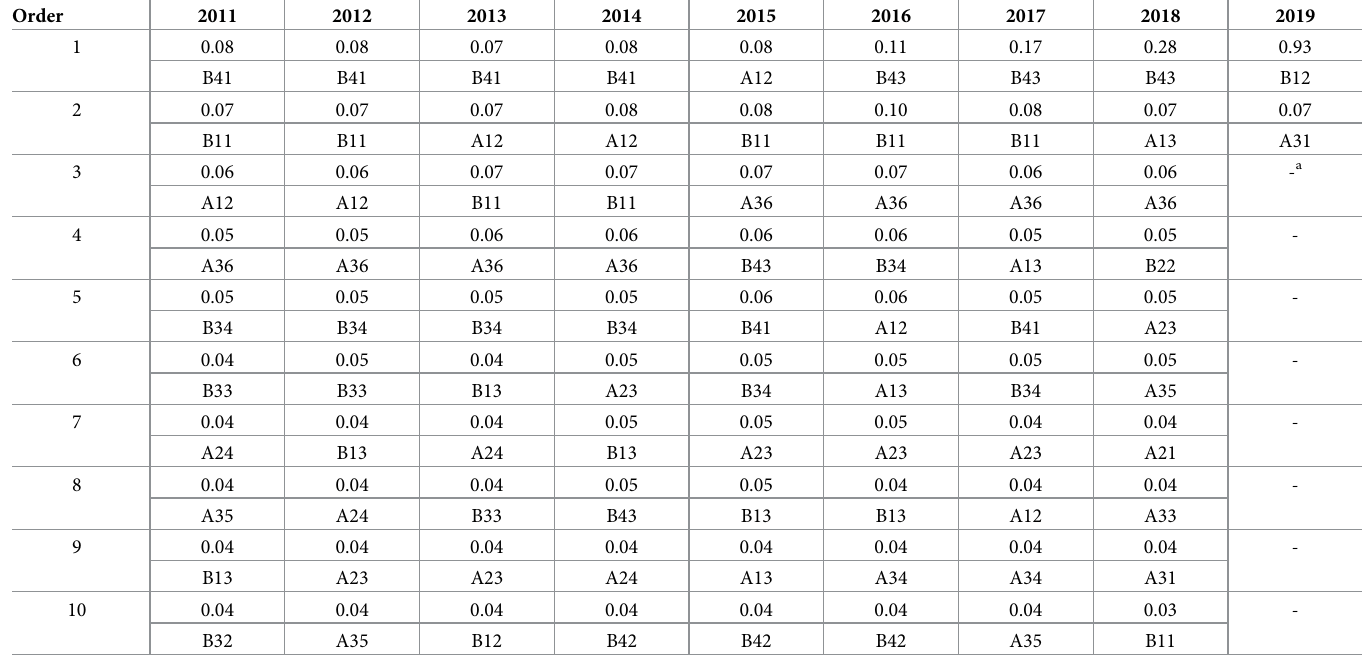
Table 5. Top 10 indicators of obstacles to pharmaceutical innovation ecological rainforest in Zhejiang Province. Order